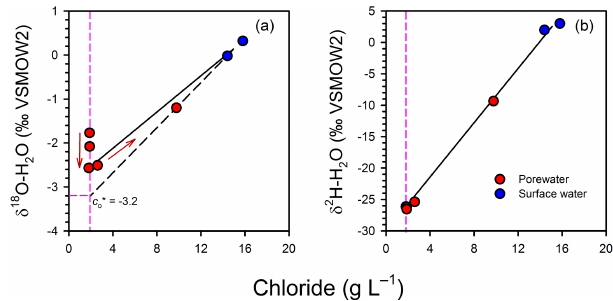
Figure 9. Mixing model for the isotopic composition of water for Profile 2, showing a small depletion trend upward in the profiles for δ 18 O H (a) but not δ 2 H H (b) . The red arrows indicate the posi- 2 O 2 O tion of the samples in the profile, from bottom to top, highlighting that the depletion trend for δ 18 O H is continuous. When corrected 2 O for mixing, δ 18 O H would be − 3 . 2‰ at the top of the profile, 2 O representing a − 1 . 4‰ shift relative to the base of the profile.